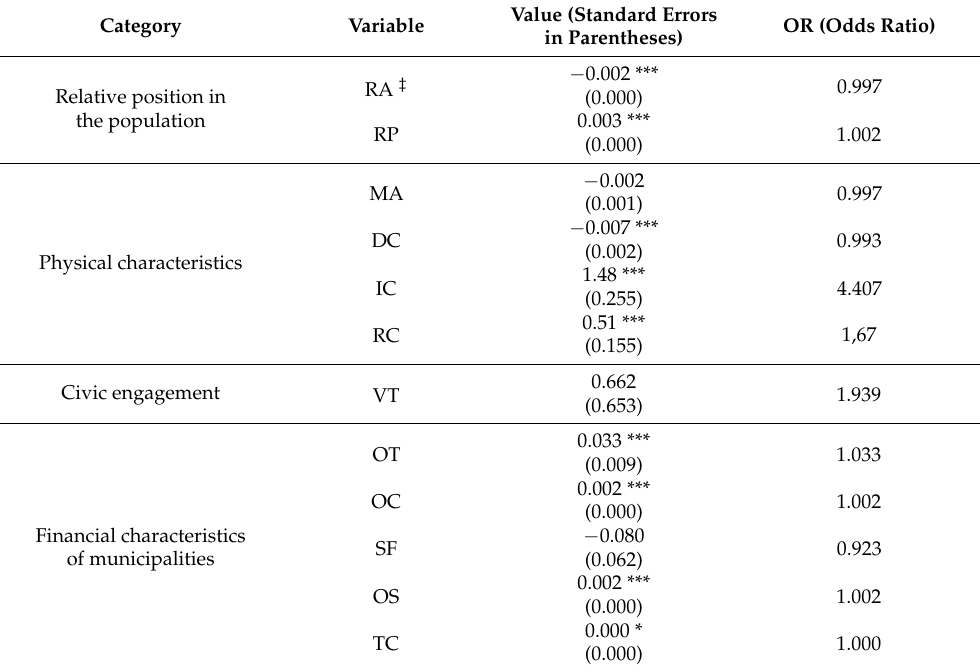
Table 7. Results of estimation of multinomial ordered logit with dependent variable—value of territorial CI in 2017 by 5